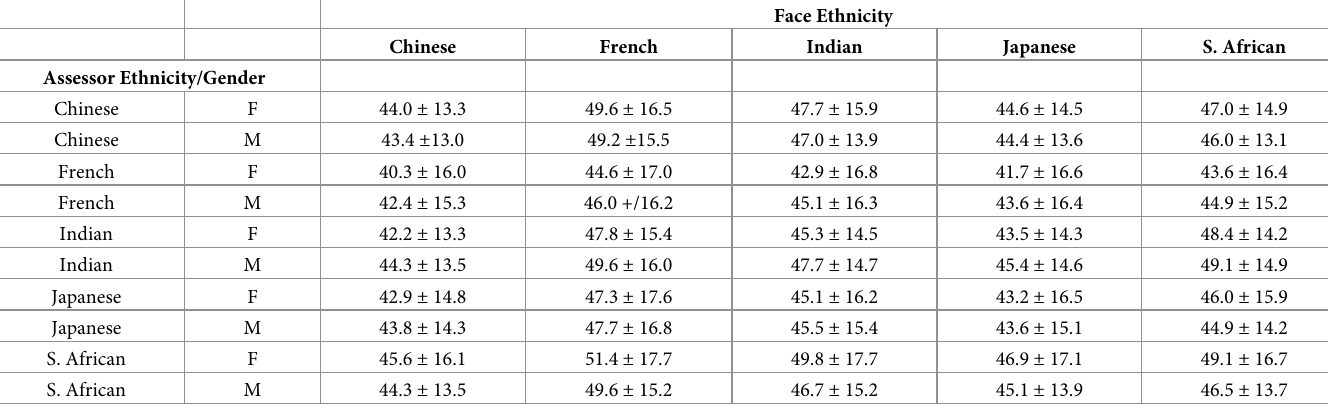
Table 4. Descriptive statistics of age assessments, separately for assessor ethnicity and gender, and participant (“face”) ethnicity (mean ±